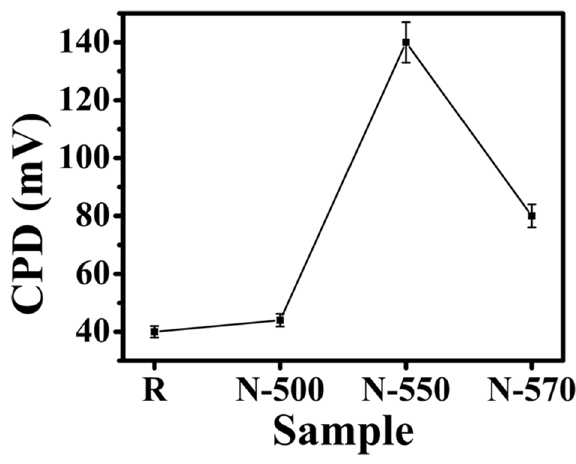
Figure 8. CPD between the NW sample and Au